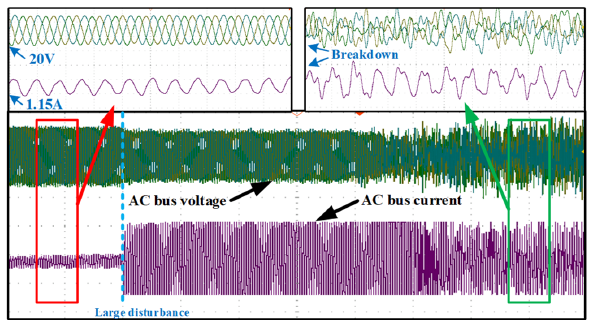
Figure 20. The curves of AC bus voltages and battery discharging current (Group B).